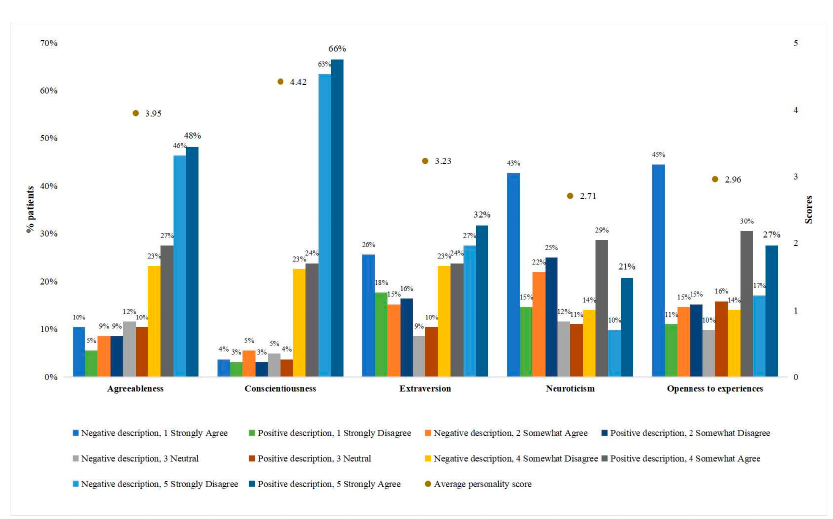
Figure A1. Personality of sample patients based on BFI-10 ( n = 164). Key: BFI, Big Five Inventory.